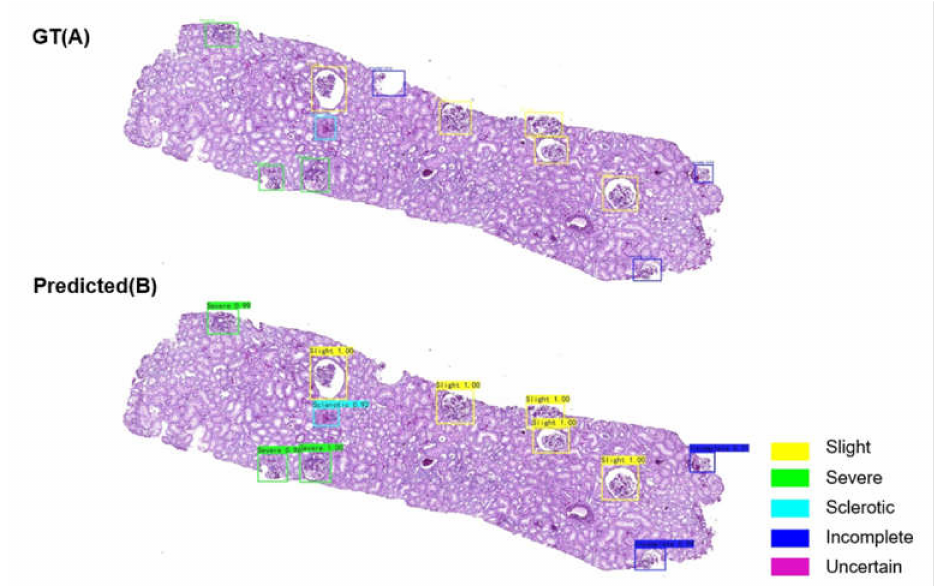
Figure 5. Ground truth (GT) and predicted glomerulus locations and categories in high-resolution images (WSIs). GT ( A ) and predicted ( B ) results for the same WSI. The top of the box is labelled with the category name and confidence level of the glomerulus that was